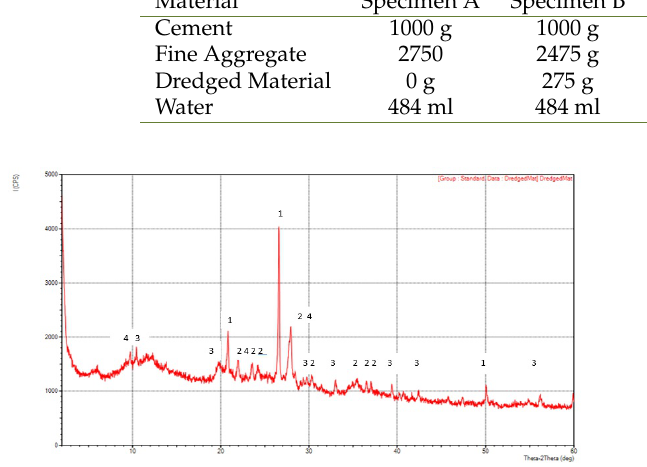
Fig. 2. XRD analysis of dredged material (1: quartz, 2: